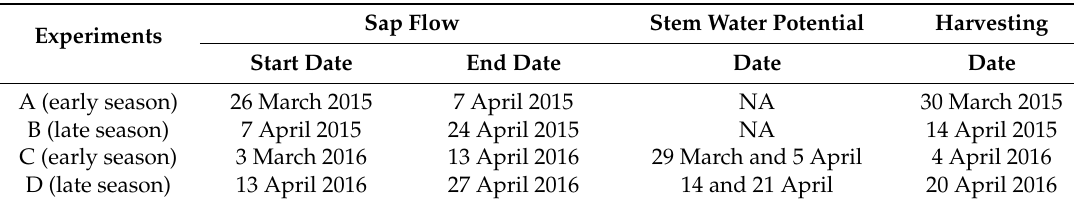
Table 1. Duration and time of each field measurements at Felda commercial site in southwest Florida during 2015 and 2016